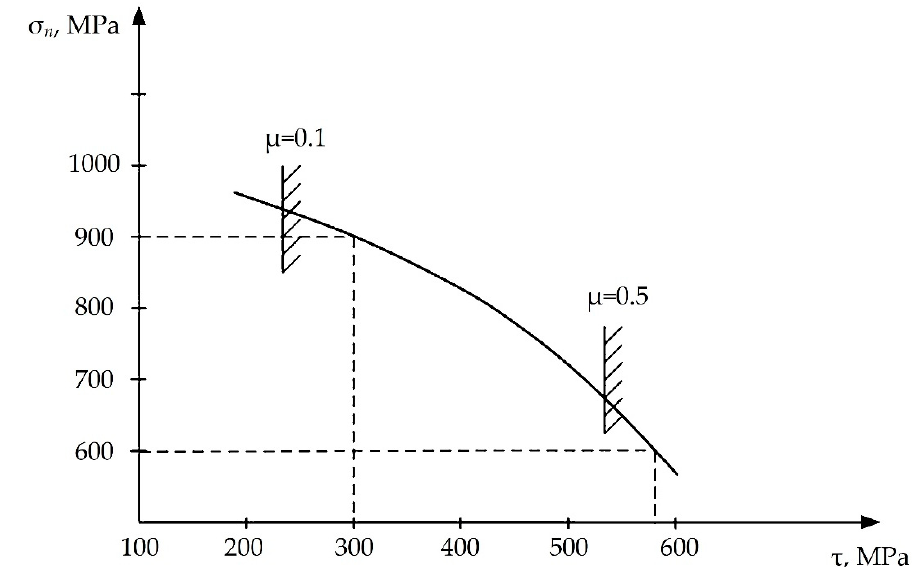
Figure 3. The interdependence of the cylinder axial stress σ n and shear stress τ in the workpiece that enables equal density of the powder preform for di ff erent frictions coe ffi cients µ , which were tested. Apart from the combination of stresses, the crucial factor a ff ecting forming is the friction coe ffi cient µ between the interacting surfaces of the wall and powder preform—die-wall friction [64,65]. When µ is below a certain value, increasing τ results in unwanted slipping between the tool and the powder preform surface that breaks the process [43]. The diagram shows two example values of µ that in e ff ect put a limit on increasing τ